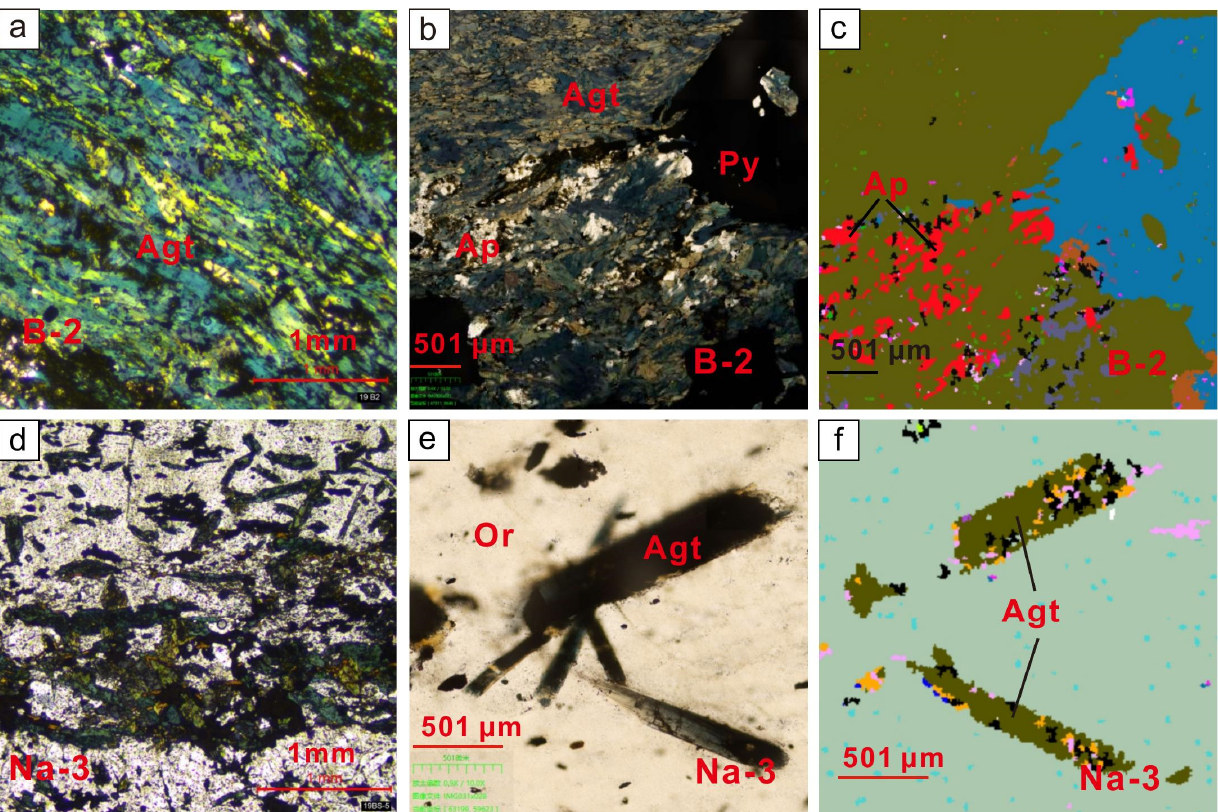
Figure 7. Aegirine-augite occurs in both aggregate forms ( a – c ) and columnar forms ( d – f ). Agt— Aegirine-augite; Ap—Biotite; Or—Orthoclase; Py—Pyrite.